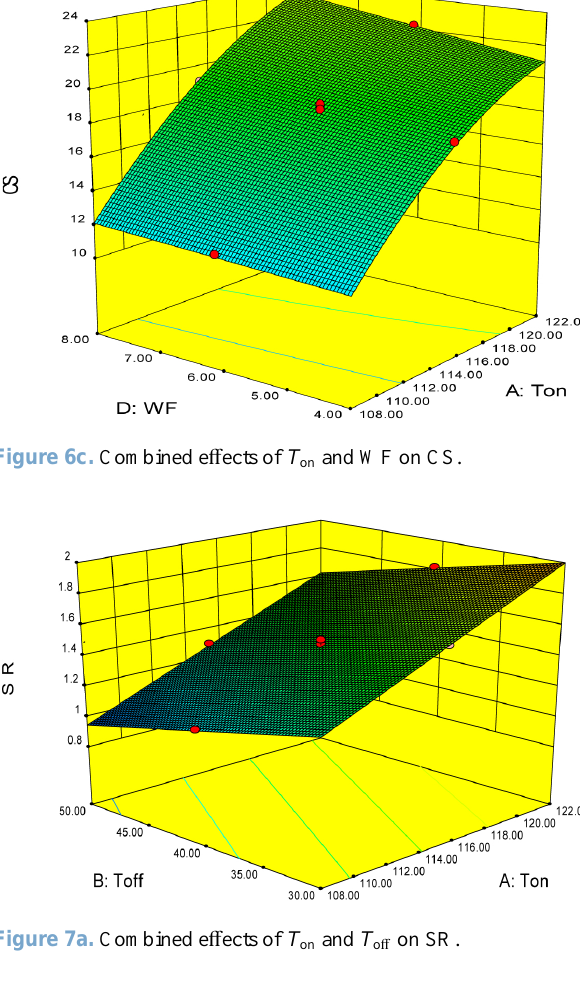
Figure 6b. Combined e ff ect of SV and WF on CS.